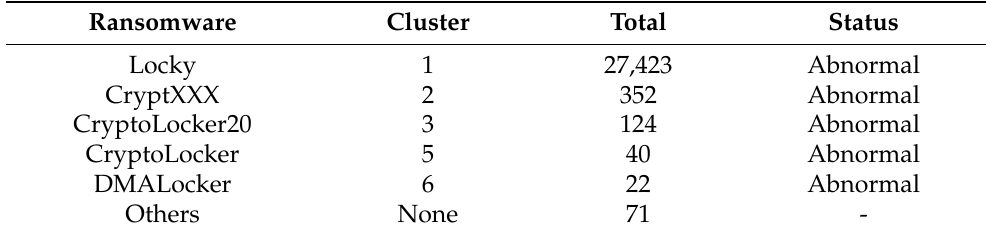
Figure 14. Imbalanced network protocols of the Bonet malware. The overall experiment indicates that the selected UGR’16 files are imbalanced. The expanded rel-outgoing.csv file was the second file used to extract ransomware features. This file has 28,104 rows and eight columns. Features extracted from this file are shown in Table 6 with the Locky malware classified as the most relevant ransomware (27,423). Table 6. The PCA results on the ransomware dataset.